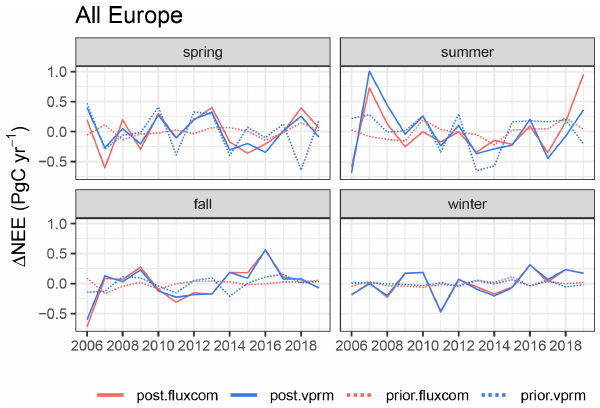
Figure 8. Anomalies of NEE fluxes during spring, summer, fall, and winter estimated from two inversion runs differing in biosphere models (FLUXCOM in red colour and VPRM in blue colour) using the atmospheric data of core sites. Solid lines indicate the a posteri- ori anomalies, while dashed lines refer to the corresponding a priori (biosphere models)